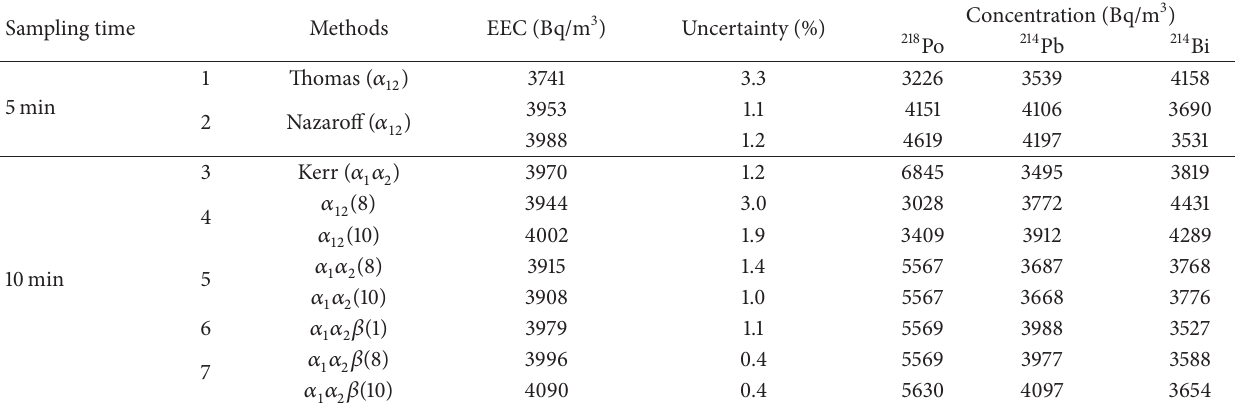
Table 2: Experimental results of different methods.